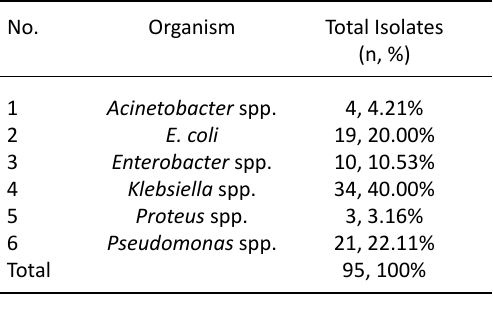
table 4. Prevalence of carbapenem resistance among multidrug resistant isolates